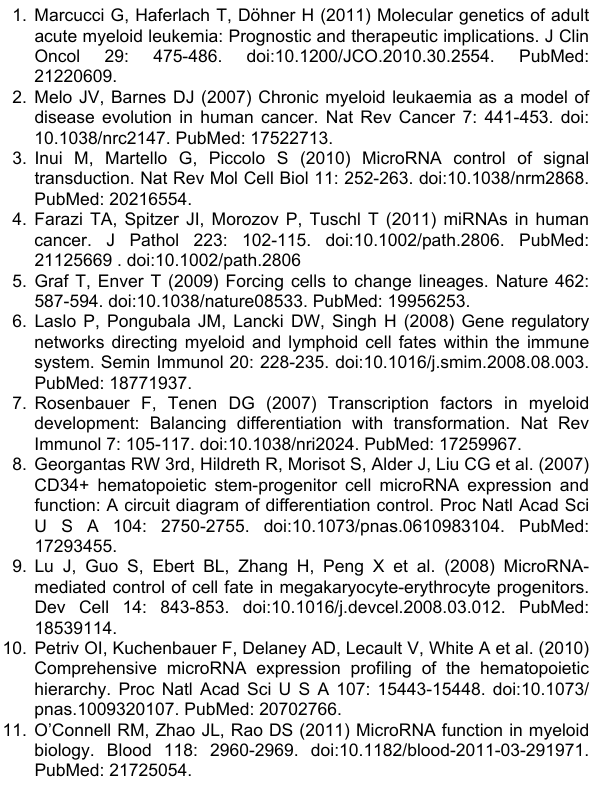
Table S4. Top statistically significant putative miR-150 targets decreased in PL21, HL60, and THP1 cells. Top statistically significant putative miR-150 targets with the largest decreases in gene expression sorted by statistical significance all 3 cell lines (combined analysis, S4D). The source of the target prediction is shown in addition to the confidence level associated with this prediction. The z-score refers to the statistical significance of decreased gene expression in the array data in miR-150 cells as compared to control cells.